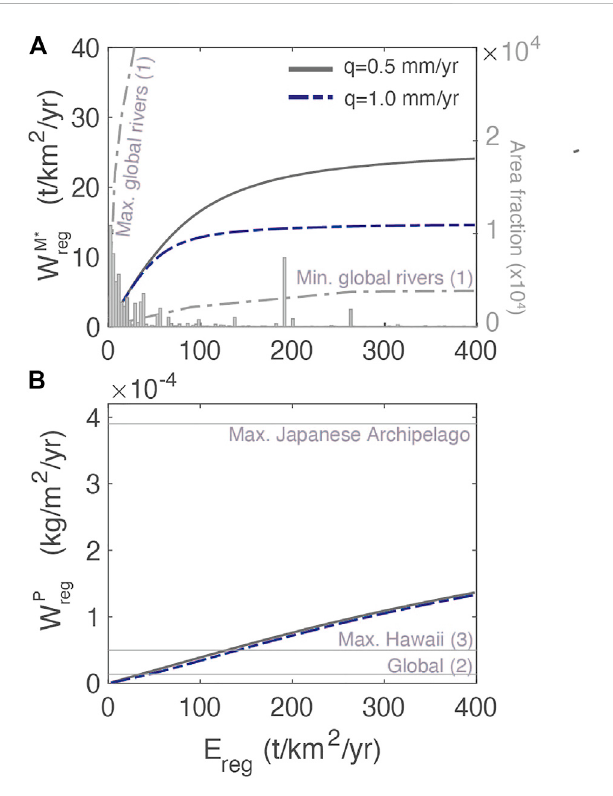
FIGURE 5 Weathering fl uxes as a function of total regolith erosion rate for dissolved primary mineral [M*] dis (A) and for dissolved phosphorus (B) . In (A) and right axis, histogram of the distribution of global erosion rates with data from Milliman and Syvitski (1992). Comparison to other estimates include: (1) the range of dissolved fl uxes from Dixon and von Blanckenburg (2012), (2) the maximum observed P fl ux in the Japanese Archipelago and the global estimate (both from Hartmann and Moosdorf, 2011), and (3) young soils from Hawaii (Chadwick et al.,